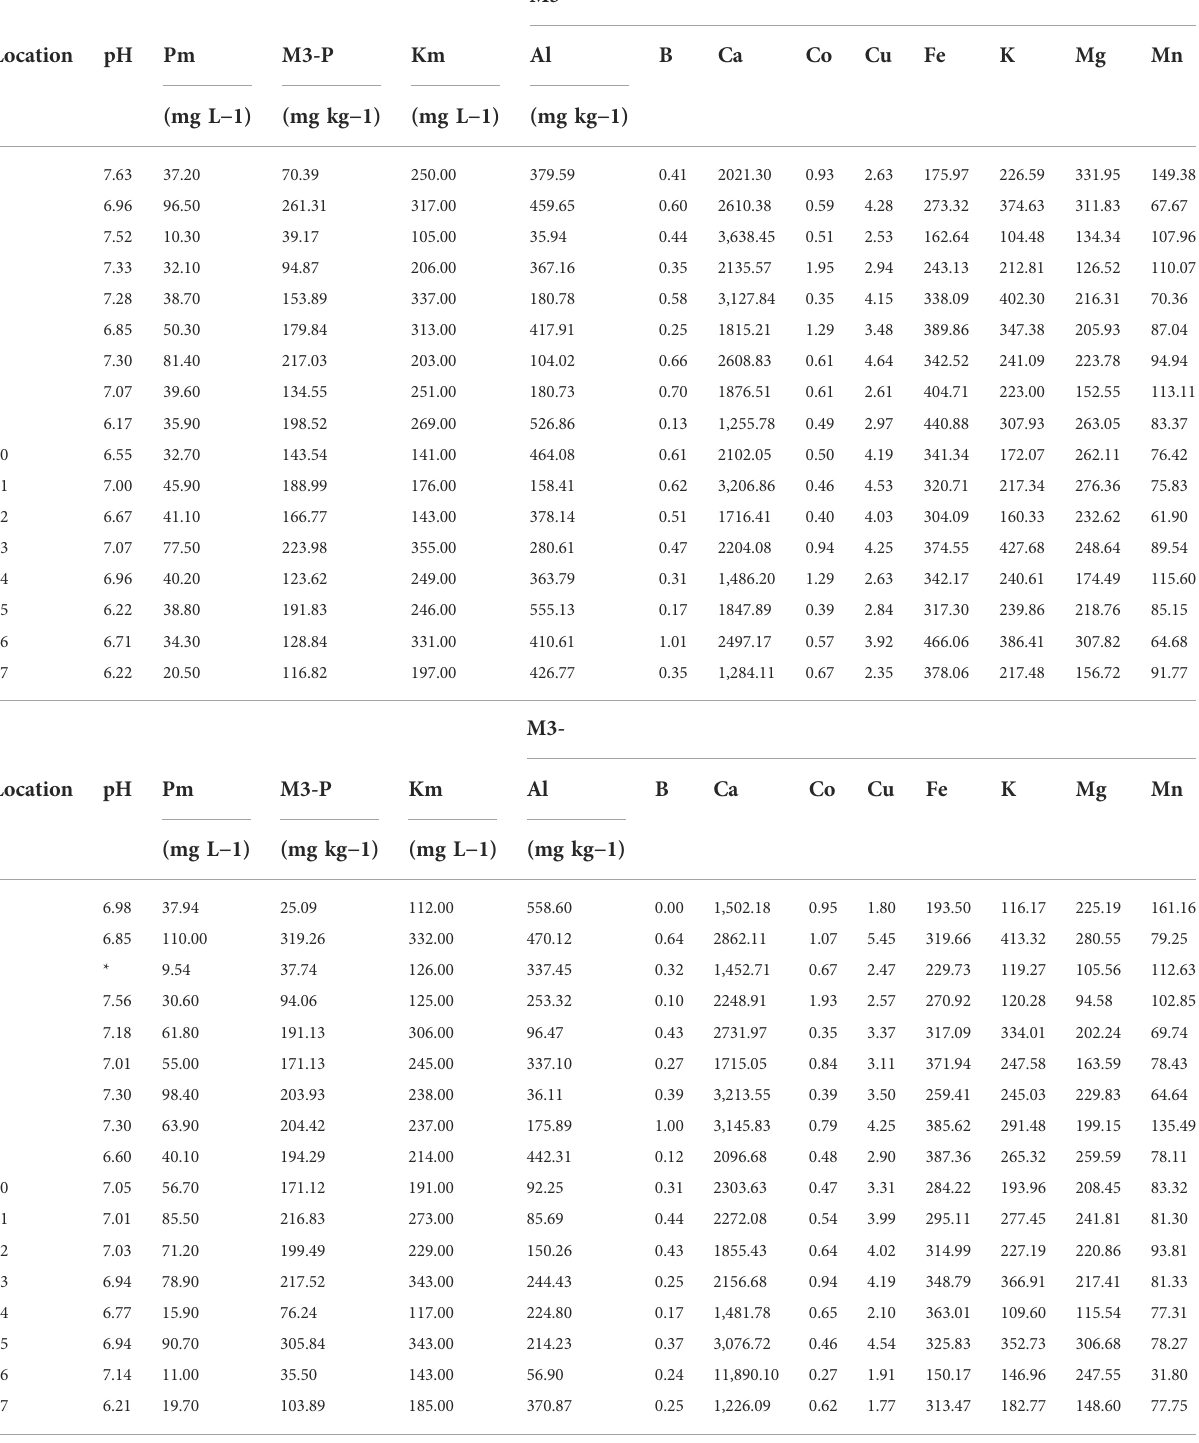
TABLE 2 Chemical properties of roadway samples collected on September 2021 (Panel A). Chemical properties of roadway samples collected on October 2021 (panel B).